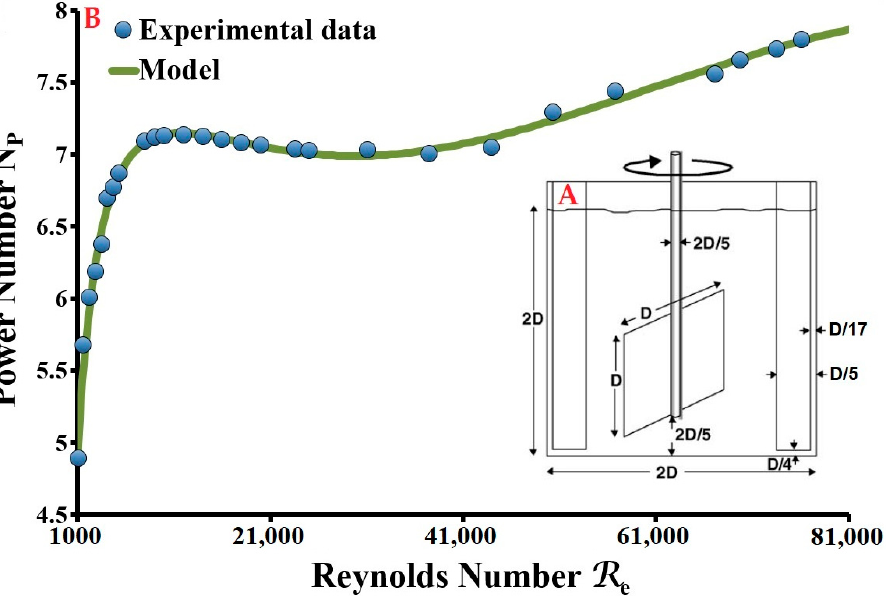
Figure 1. Laboratory conditioning system. ( A ) Geometrical configuration of the reactor; ( B ) Power diagram of the single-blade sheet-type agitator.